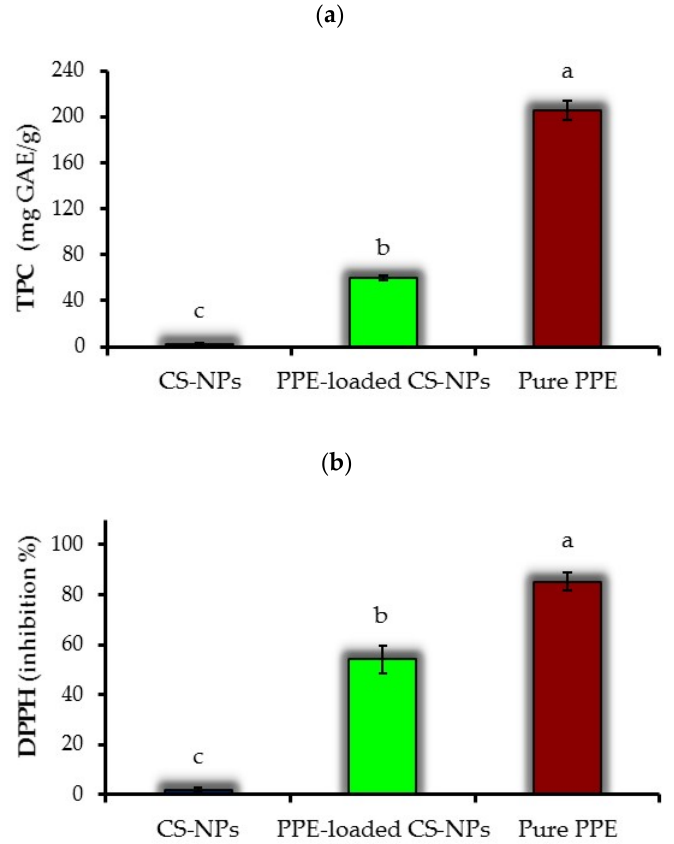
Figure 5. Results of ( a ) TPC and ( b ) DPPH-RSA measured for PPE, empty CSNPs and PPE-loaded CSNPs (at chitosan:PPE ratio of 1:0.50 w / w ). Data represent the average of triplicate measurements. Error bars show standard deviations. Different alphabetical letters indicate significant ( p < 0.05) differences between means.